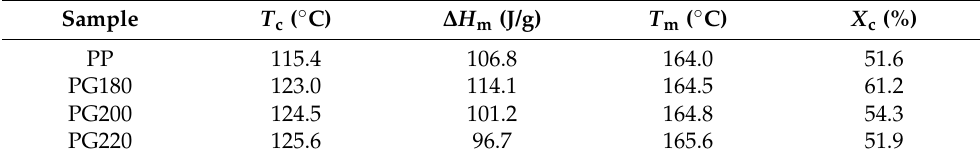
Table 1. DSC thermal performance parameters for neat PP and PP/GIC composite